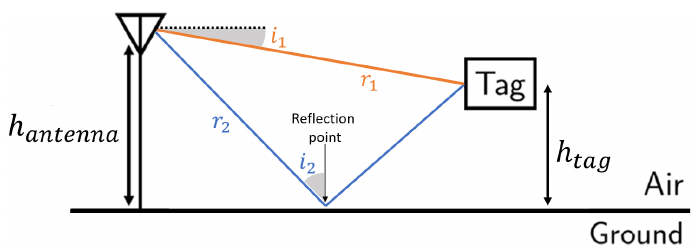
Figure 3. Schematic definition of the two-ray multipath model. The orange line represents the line-of-sight path with angle i 1 and propagation distance r 1 . The blue line represents the reflected path with angle i 2 and propagation distance r 2 . h tag and h antenna are the tag and antenna heights above